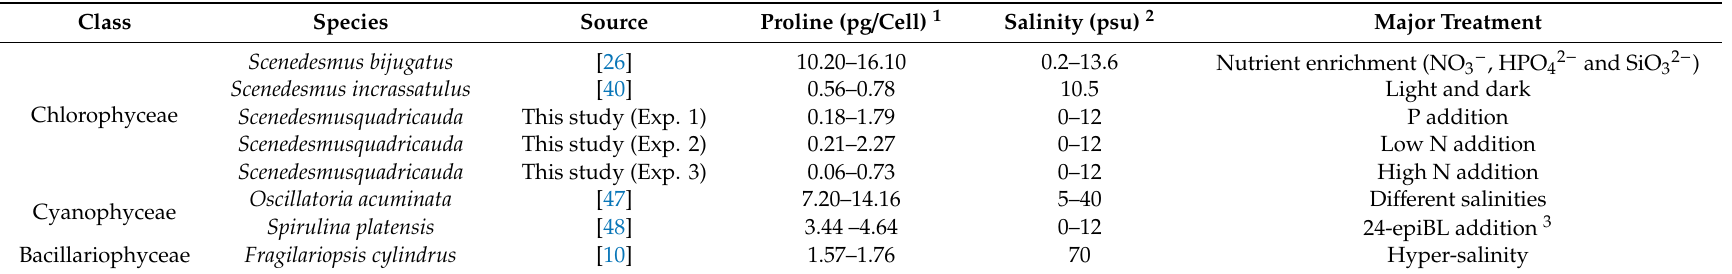
Table 2. Comparison of cellular proline contents in di ff erent algal species under di ff erent salinity and treatment